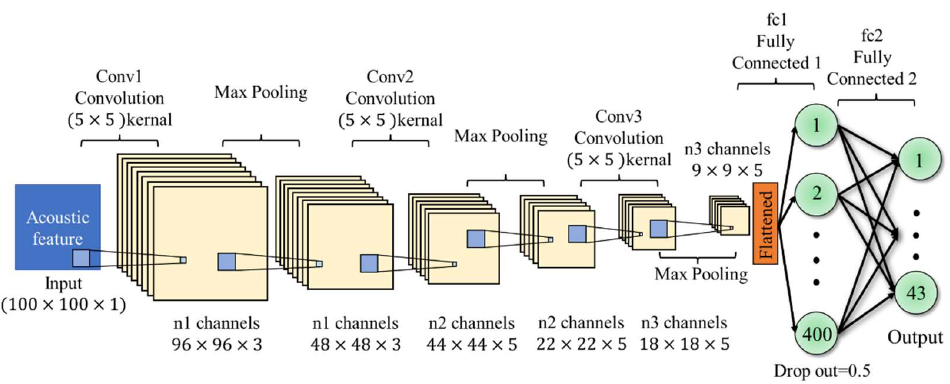
Figure 16. CNN architecture.